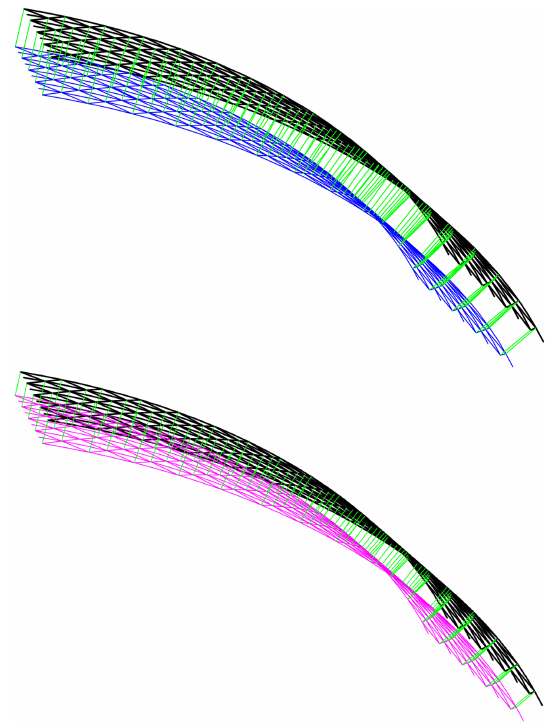
Figure 6: Fragment of the double-layer lattice dome of the shape based on the two-sheet rotational hyperboloid